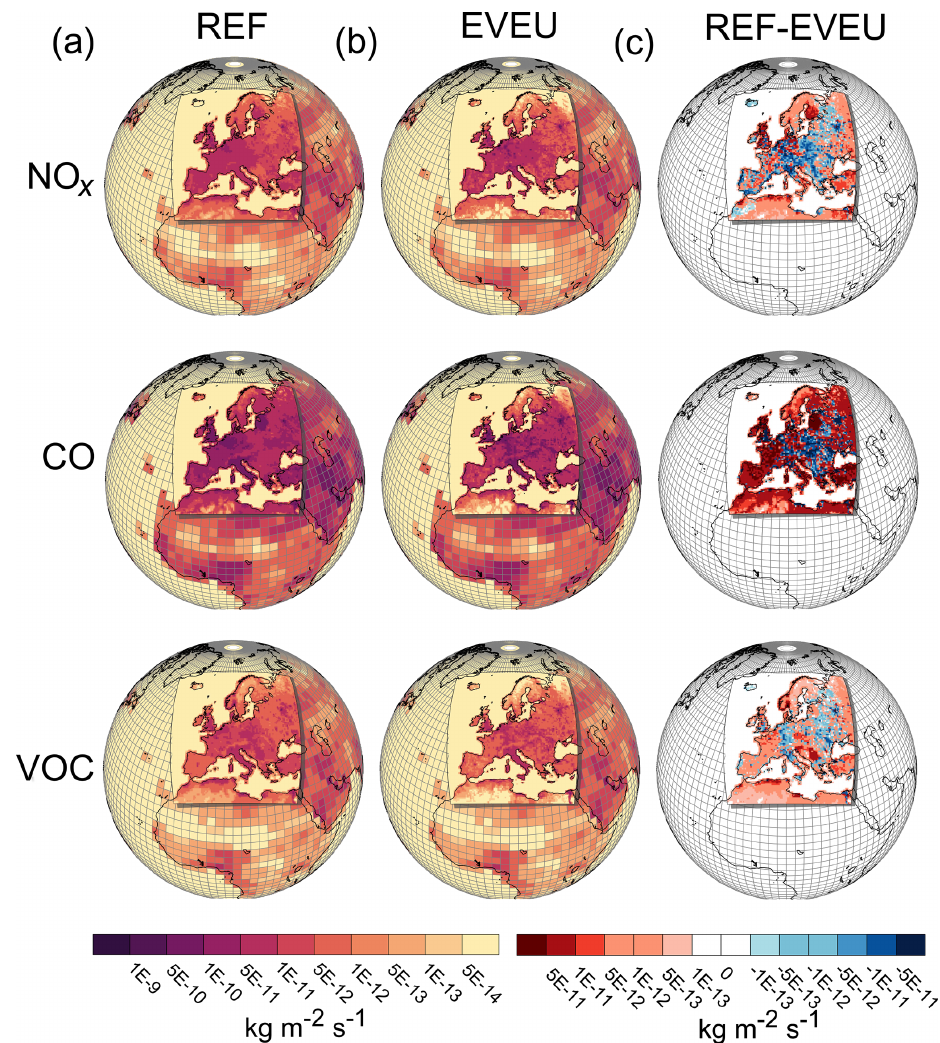
Figure 1. Annually averaged emission fluxes (2008 to 2010) from the land transport sector (in kgm − 2 s − 1 ). Shown are the emissions as applied in EMAC (based on the MACCity inventory) and in CM50. The emissions of CM50 are superimposed on the emissions of EMAC. In the region covered by CM50, EMAC also uses the MACCity emissions (not visible). (a) The emissions applied in REF , (b) the emissions applied in EVEU , and (c) the difference of the emissions between REF and EVEU (“REF − EVEU”). Shown are the emission fluxes of NO x